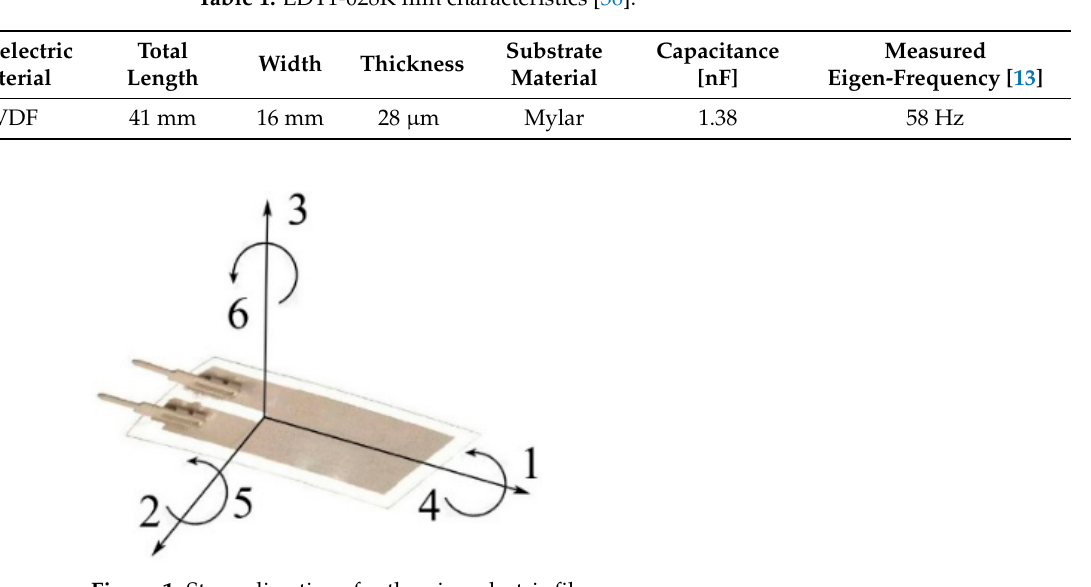
Figure 1. Stress directions for the piezoelectric film. As the piezo film is used as a flutter-type harvester, it is subjected to bending, and the stress is mainly in direction 1. The values of the piezoelectric charge coefficients are given in Table 2. Table 2. Piezoelectric charge coefficients for PVDF